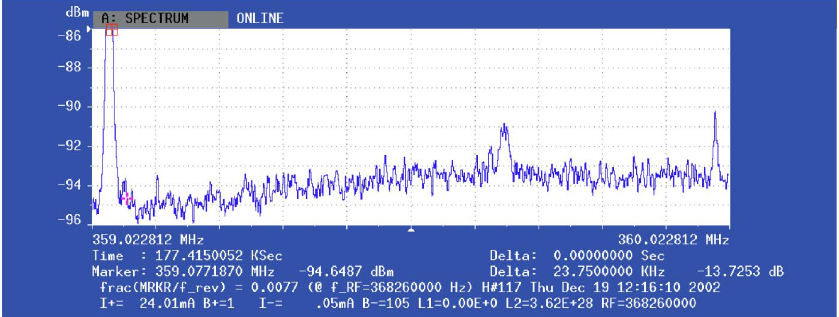
FIG. 19. (Color) Same configuration of the previous figure, but with the LFB on and correctly set: the q -pole excitation is